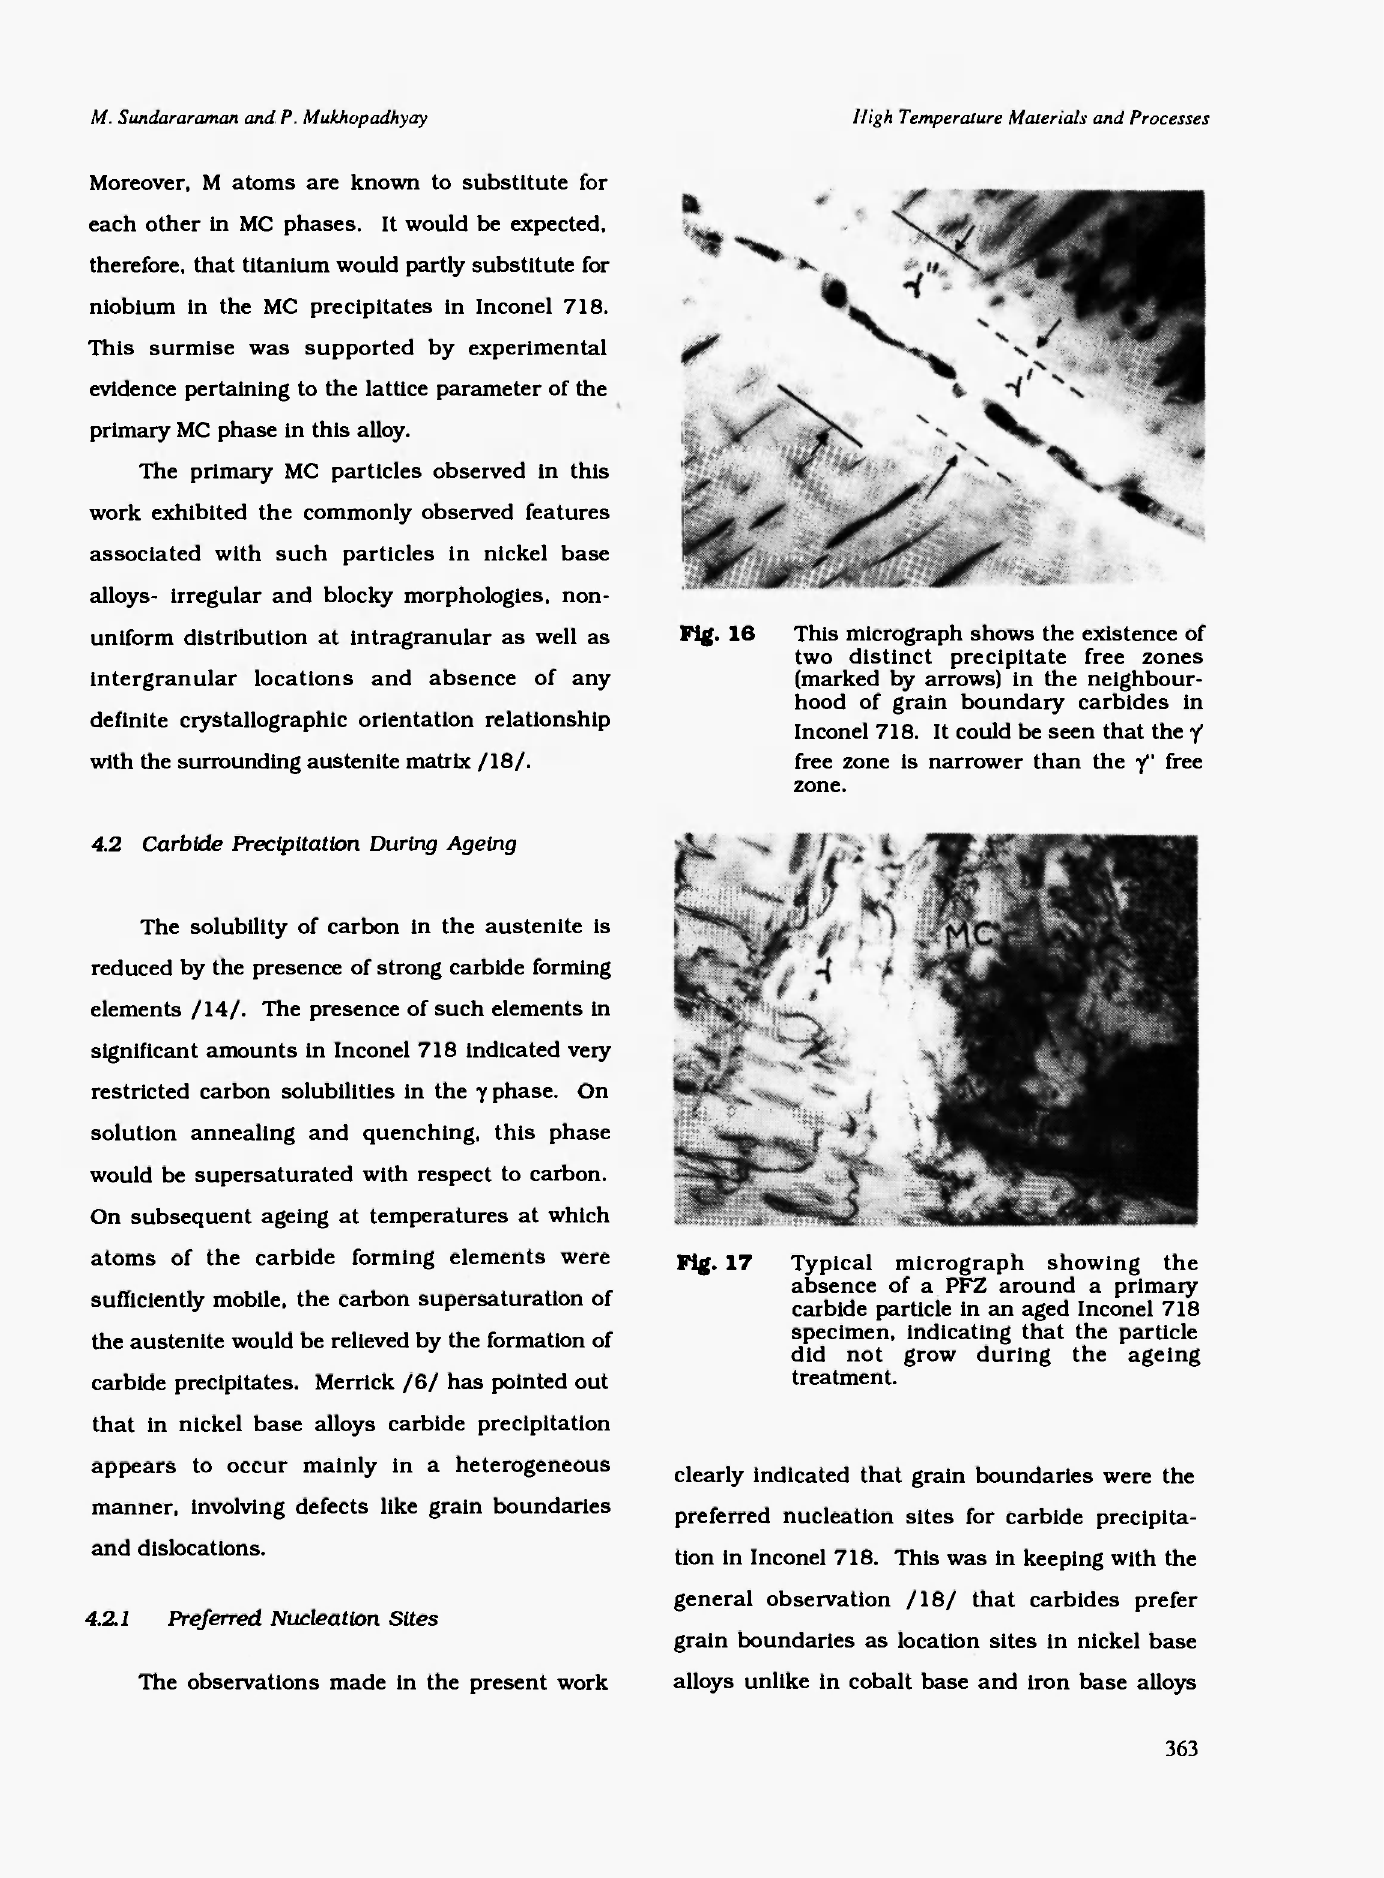
Fig. 16 This micrograph shows the existence of two distinct precipitate free zones (marked by arrows) in the neighbour- hood of grain boundary carbides in Inconel 718. It could be seen that the γ free zone is narrower than the γ" free zone.